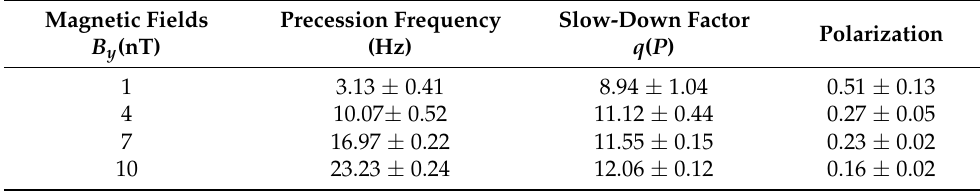
Table 4. P z response measurement results under different magnetic